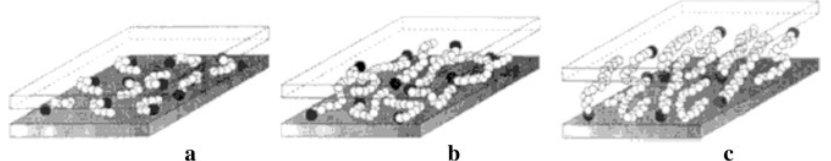
Figure 5. Schematic illustration of chains aggregation models in alkyl-modified organoclays: ( a ) short chains length, lateral monolayer; ( b ) medium chains length, in-plane disorder and interdigitation to form quasi bilayers; ( c ) long chains length: interlayer order increases leading to a liquid–crystalline polymer environment. Reprinted with permission from [135]. Copyright 1994 American Chemical Society.